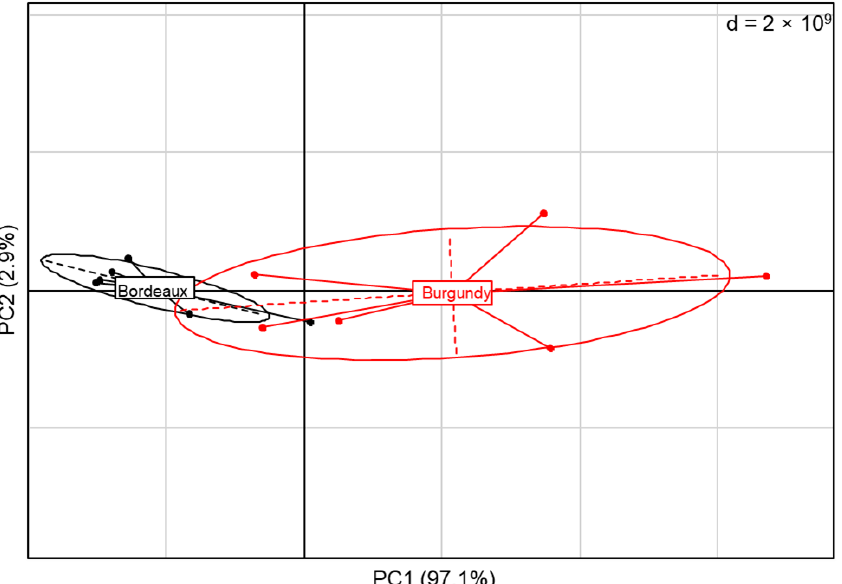
Figure 5. Principal component analysis (PCA) of total terpenes emission in the vineyards in 2019. Values correspond to the sum of mono- or sesquiterpenes detected in response to Bastid ® treatment at two time points and at three phenological stages of grapevines in Burgundy (cv. Chardonnay) and Bordeaux (cv. Cabernet franc) vineyards.